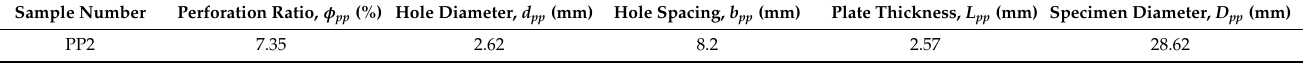
Figure 8. The optimized composite structure: ( a ) 3D printed PP2 sample; ( b ) Top view; ( c ) Side view. Table 4. The measured structural parameters for PP2 test specimen.